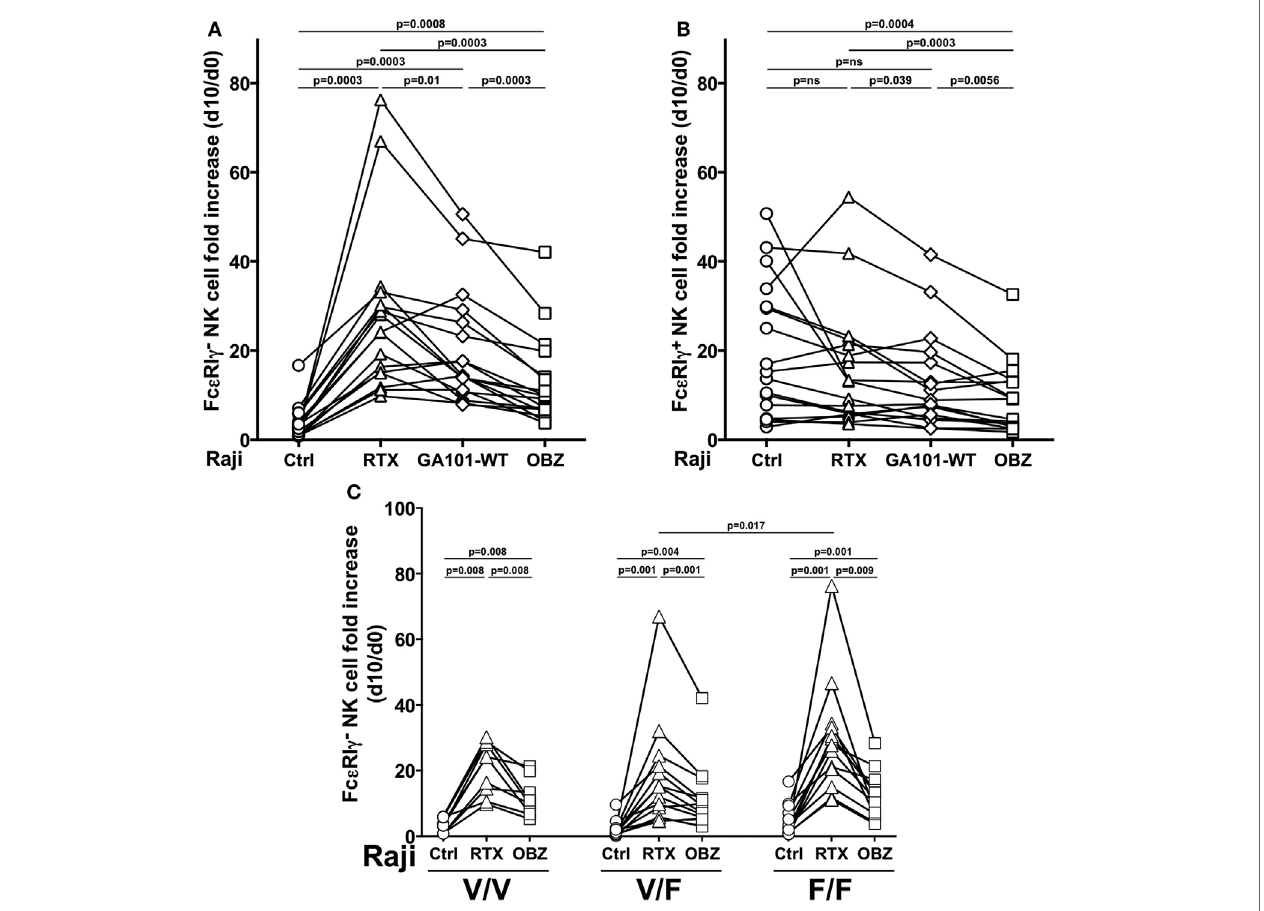
FigUre 3 | Effect of CD16 affinity ligation conditions on memory natural killer (NK) cell in vitro expansion from HCMV + individuals. (a) Memory (Fc ε RI γ − ) and (B) conventional (Fc ε RI γ + ) CD3 − CD56 dim CD16 + NK cell fold increase, in response to the presence of Raji opsonized, or not (Ctrl), with rituximab (RTX), glycoengineered obinutuzumab (OBZ), or wild-type OBZ (GA101-WT). (c) Memory NK cell fold increase in response to rituximab or glycoengineered OBZ in samples stratified according to donor’s CD16 allotype; Only statistically significant comparisons are depicted. Donors reported in Figures 2B–c are included. p values of pairwise comparisons are from Wilcoxon and from Mann–Whitney non-parametric tests, as